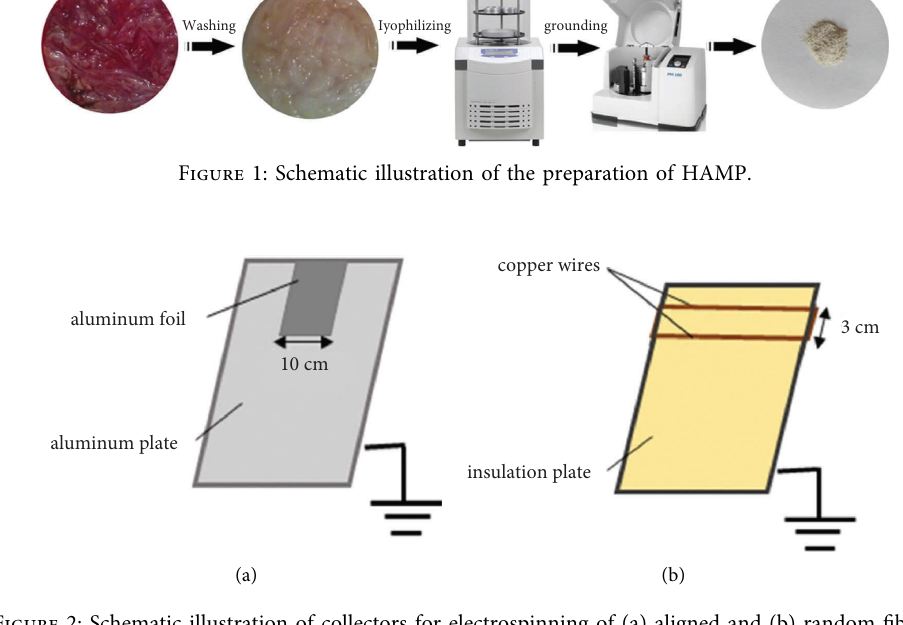
Figure 2: Schematic illustration of collectors for electrospinning of (a) aligned and (b) random fbers.